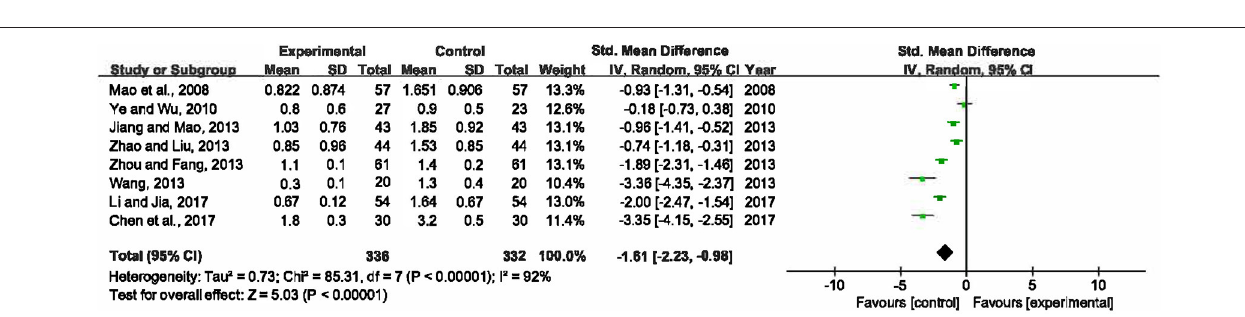
FIGURE 7 | Forest plot of serum PCT levels in sepsis patients treated with XBJ + UTI therapy and UTI alone.